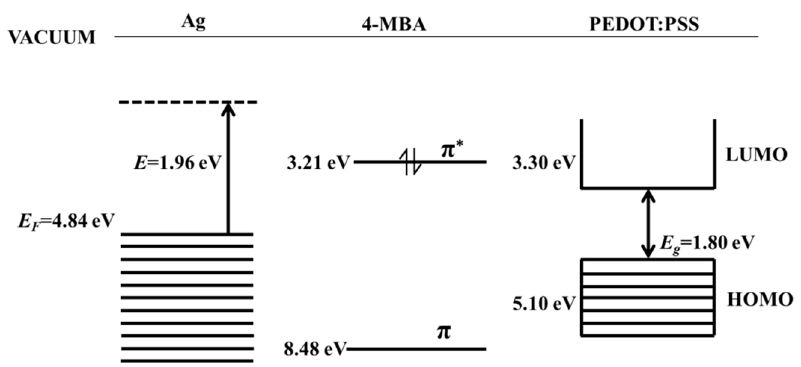
Figure 7. CT mechanism in terms of the Ag/4-MBA/PEDOT:PSS energy level diagram.